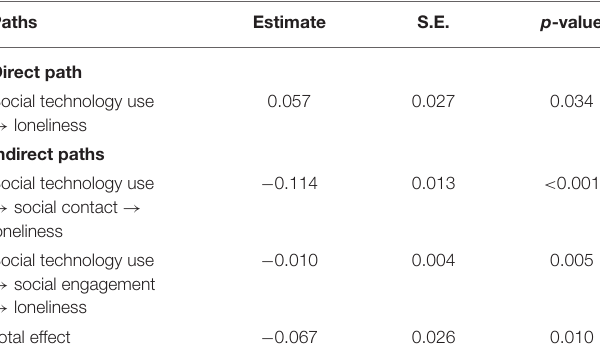
TABLE 5 | Effect of social technology on loneliness as mediated by social contact and social engagement.